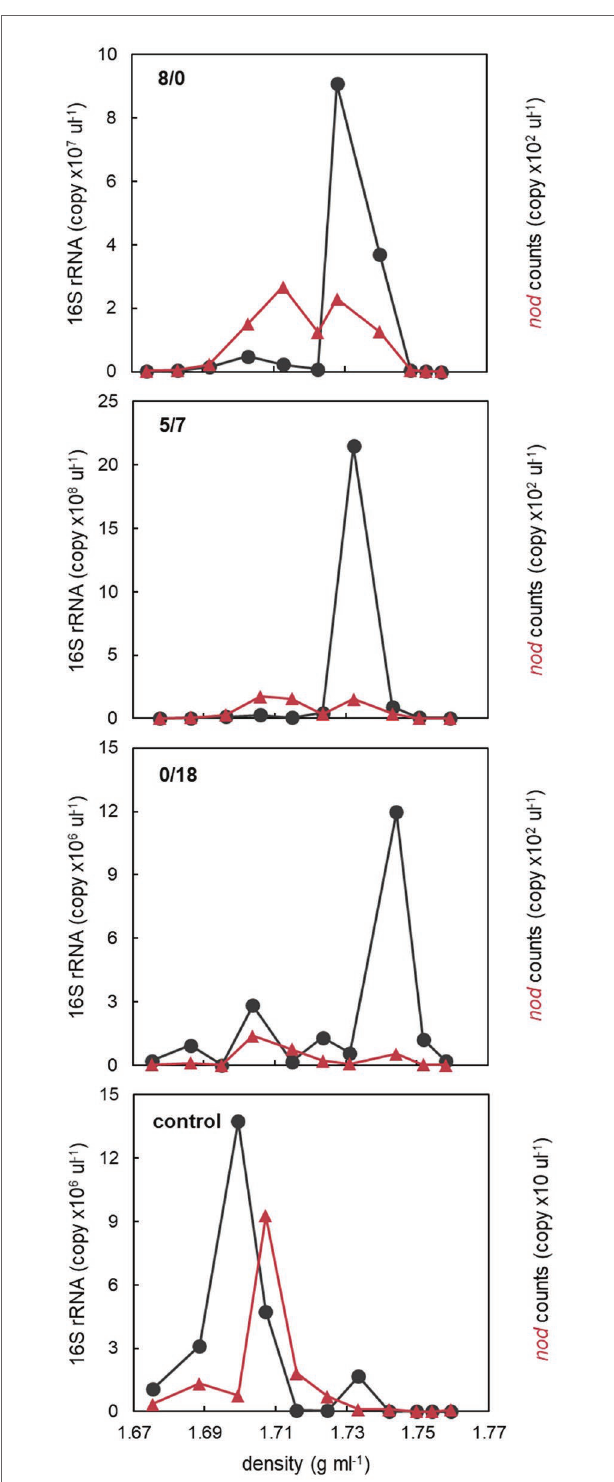
FIGURE 2 | The abundance distribution of all bacteria (16S rRNA) and oxygenic denitrifiers ( nod ) along the density gradients of the 8/0, 5/7, 0/18, and the control microcosms. For each microcosm, DNA recovered from the fractions with highest 16S rRNA or nod counts at both light and heavy densities were used for amplicon sequencing